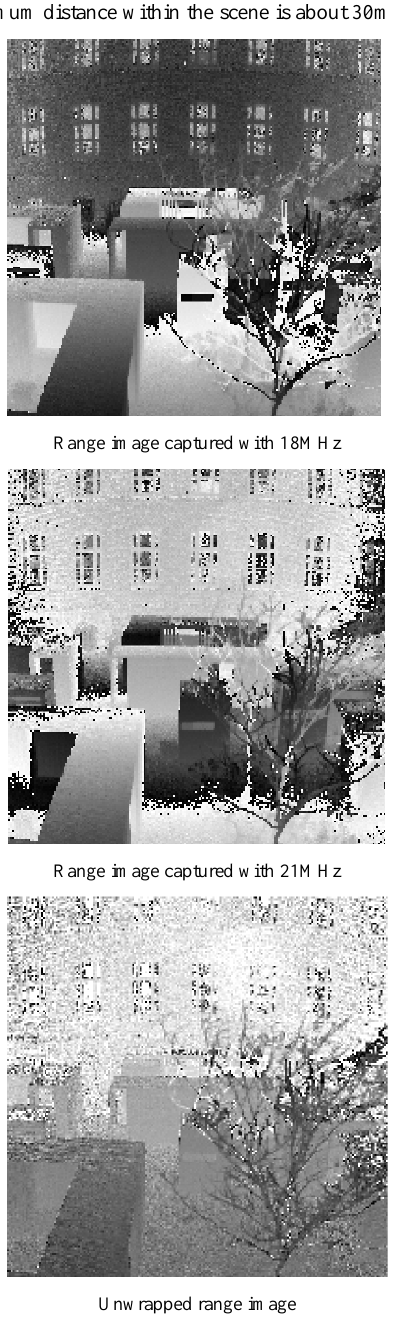
Figure 1. Range images captured with different modulation frequencies (top: 18MHz; center: 21 MHz) and corresponding unwrapped range image